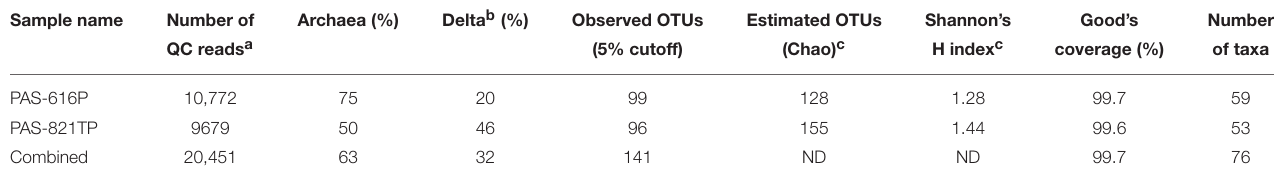
TABLE 1 | Summary of 16S amplicon sequence data and derived diversity parameters for CsCl-purified DNAs from PAS samples also used for metagenomic analysis.